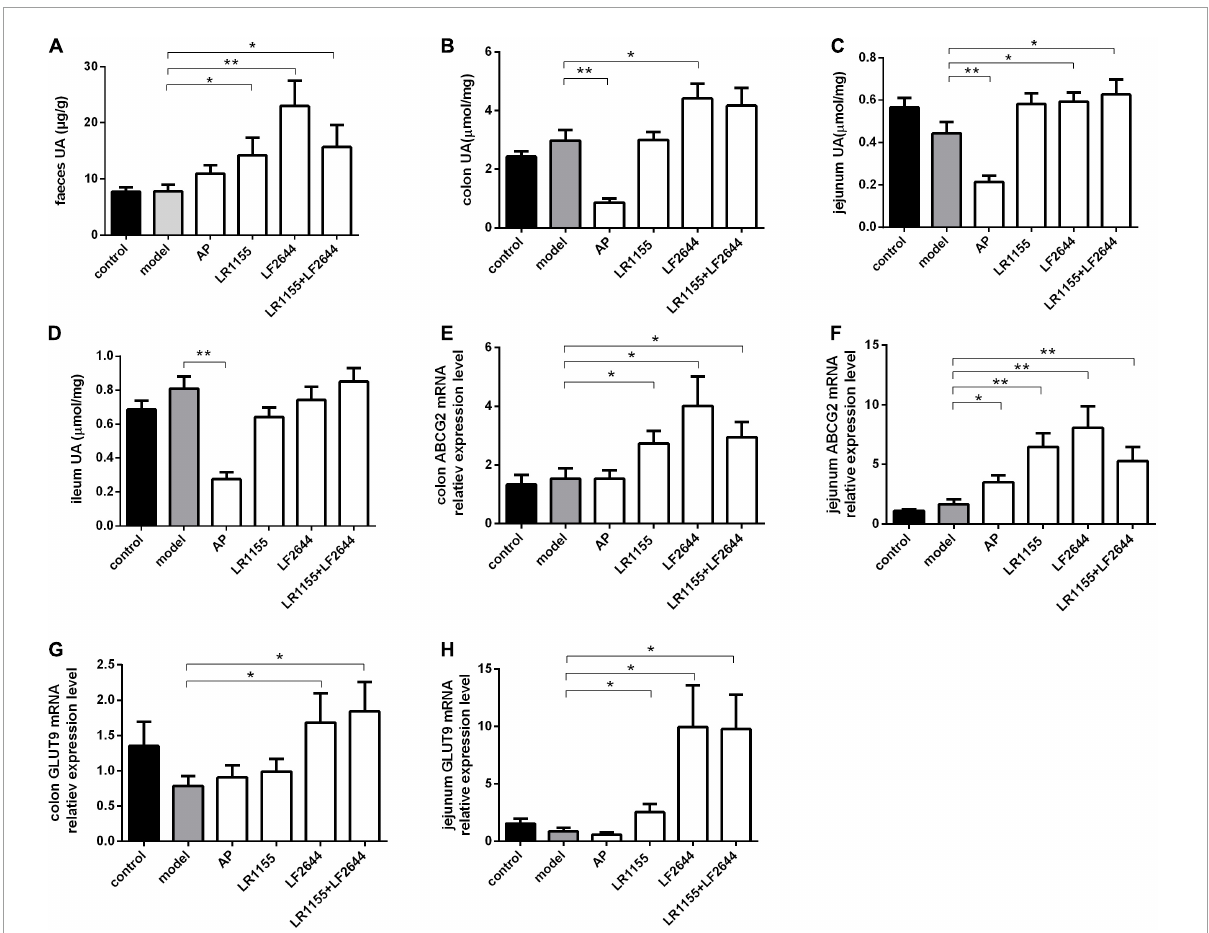
FIGURE3 Effects of LR1155 and LF2644 on intestinal uric acid excretion in hyperuricemia rats. (A) Fecal UA levels. (B–D) UA contents of colon, jejunum and ileum. (E,F) Gene expressions of ABCG2 in colon and jejunum. (G,H) Gene expressions of GLUT9 in colon and jejunum. Data are expressed as mean ± SEM ( n = 10–12 per group). * P < 0.05, ** P < 0.01 vs. the model